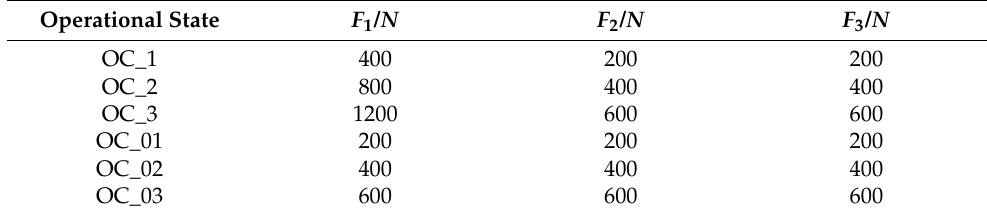
Table 3. Bearing loading conditions and operating conditions table.